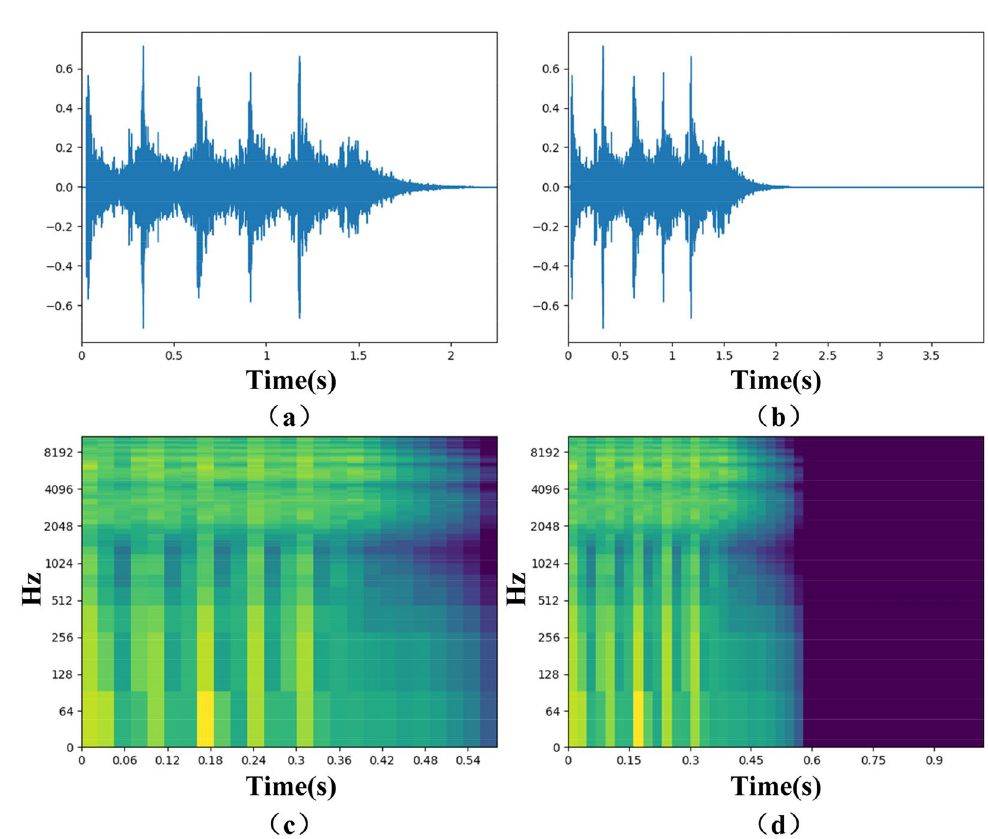
Figure 7. Visual display of audio data before and after zero padding. (( a ) and ( b ) are drawn by the plotting library Matplotlib 3.1.1, ( c ) and ( d ) are drawn by the audio processing library Librosa